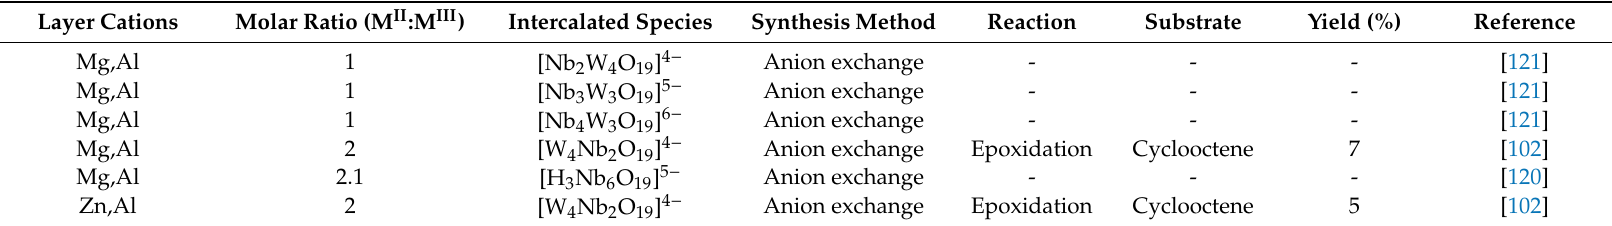
Table 10. Summary of LDH with intercalated niobium-based anions.